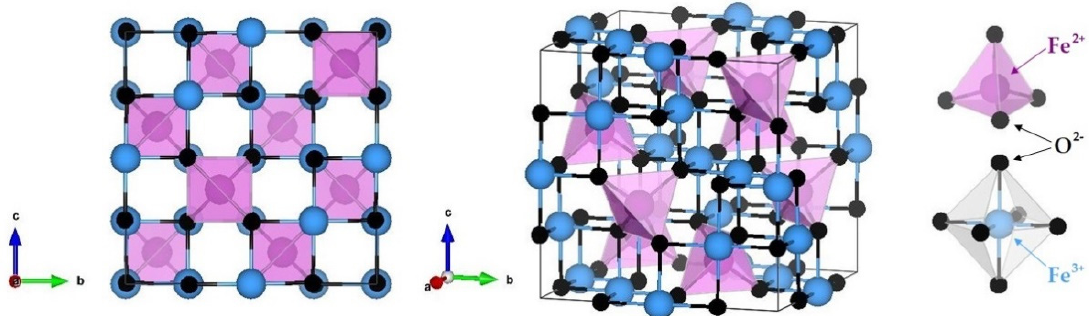
Figure 16. Spinel ferrite structure on Fe 3 O 4 NP example (octahedra not marked for clearer structure visibility).